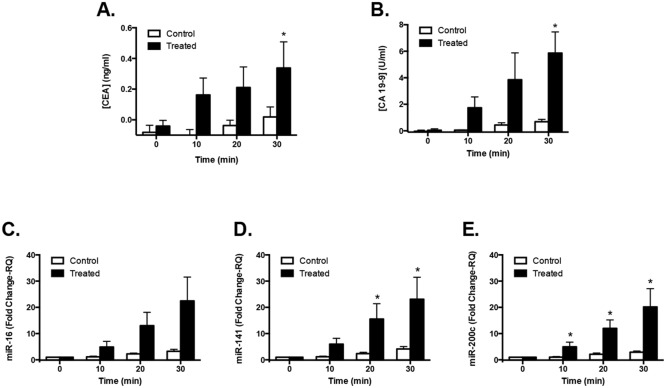
Time release of biomarkers from LS174T cells in culture treated with 0.5 W/cm2 ultrasound intensity.Cells (n = 3 wells) were exposed to a constant ultrasonic pulse (1MHz, 0.5 W/cm2, 10% duty cycle) for 30 min. All the biomarkers showed a significant (p≤0.05) increase at 30 min post-treatment with ultrasound compared to the pre-treatment time point: CEA (A), CA19-9 (B), miR-16 (C), miR-141 (D) and miR-200c (E). Untreated controls did not show significant increases. Increase of ultrasound-treated to untreated-controls at the same time point reached significance for some of the biomarkers (*p≤0.05). Error bars are SEM. RQ is relative quotient indicative of fold change.